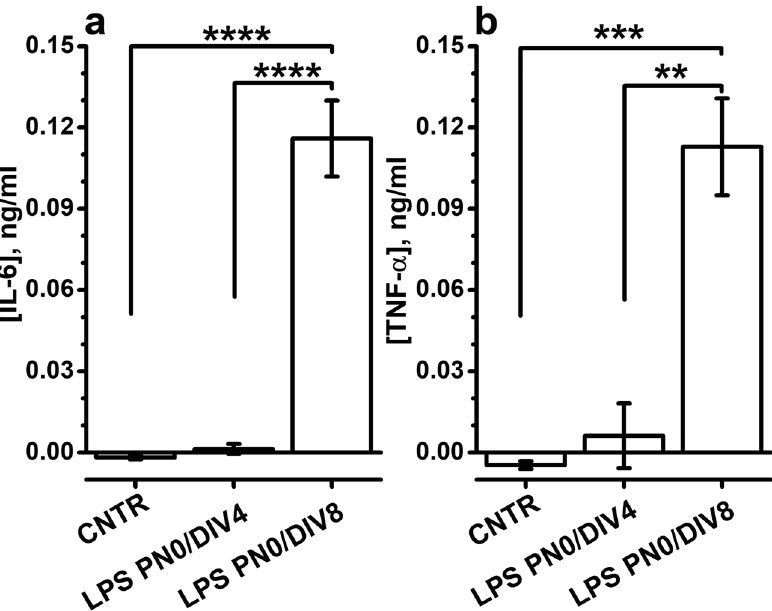
Figure 7. Low cell culture density provides permissive conditions for MG properties. ( a , b ) Columns plot IL-6 ( a ) and TNF-α ( b ) concentrations in culture medium collected at DIV4 and DIV8 after 24 incubation with 10 µg/ml LPS. CNTR plot pooled values from untreated wells at DIV4 and DIV8. ****P < 0.0001 and ***P < 0.001, respectively, by one-way ANOVA (F = 201.37909 with 2, 6 df: P = 3.16267 × 10 –6 ) for ( a ) and (F = 39.70053 with 2, 6 df: P = 3.46788 × 10 –4 ) for ( b ). Multiple comparisons with Bonferroni’s test : ( a ) CNTR vs LPS PN0/DIV4 t = 0.4806, P = 1; CNTR vs LPS PN0/DIV8 t = 17.61544, P = 6.44505 × 10 –6 ; LPS PN0/DIV4 vs LPS PNO/DIV8 t = 17.13484, P = 6.29031 × 10 –6 . ( b ) CNTR vs LPS PN0/DIV4 t = 1.62042, P = 0.46881; CNTR vs LPS PN0/DIV8 t = 8.39846, P = 4.65651 × 10 –4 ; LPS PN0/DIV4 vs LPS PNO/DIV8 t = 6.77804, P =